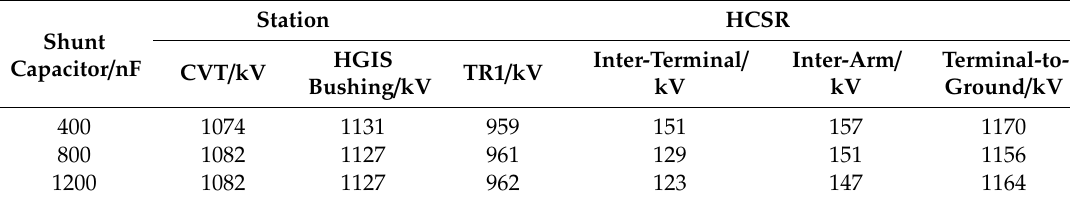
Table 16. Maximum overvoltage of the equipment with the HCSR-FCL working in current limiting state. Shunt Capacitor /